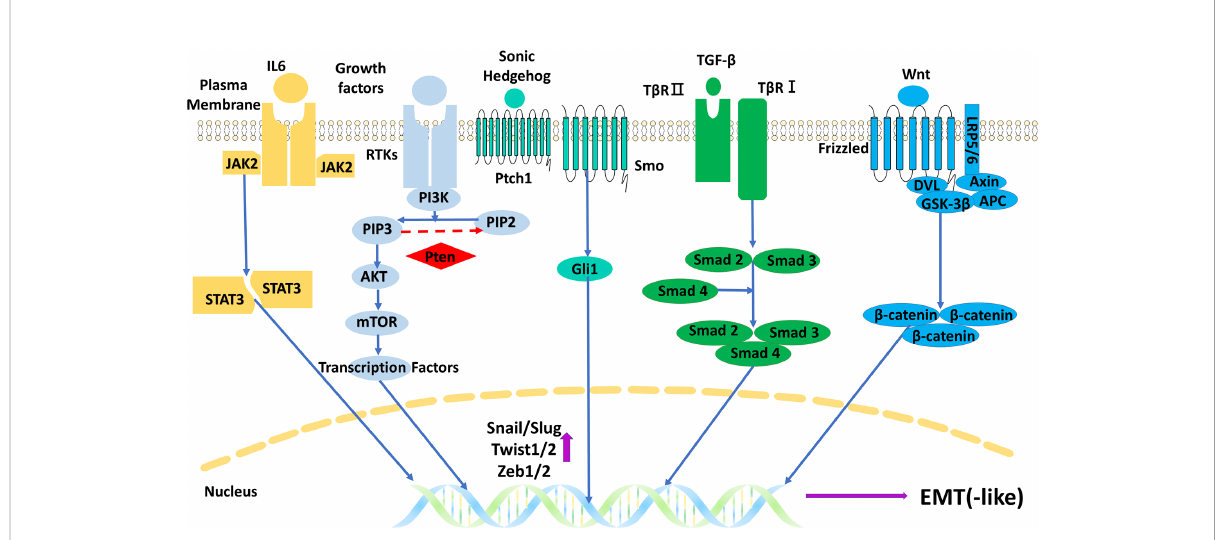
FIGURE 7 The main fi ve signal pathways regulating EMT in gliomas. EMT, epithelial – mesenchymal